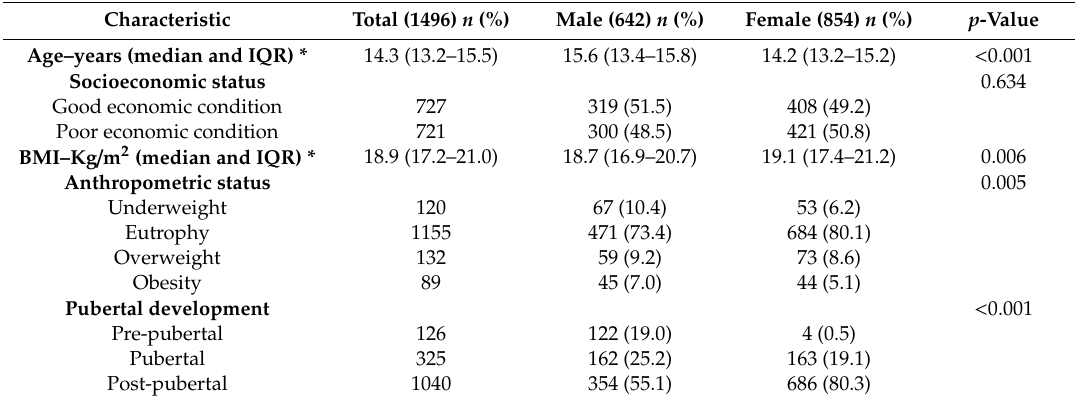
Table 2. Distribution of the demographic, economic, biological, and behavioral characteristics total and according to the sex of the adolescents enrolled in the